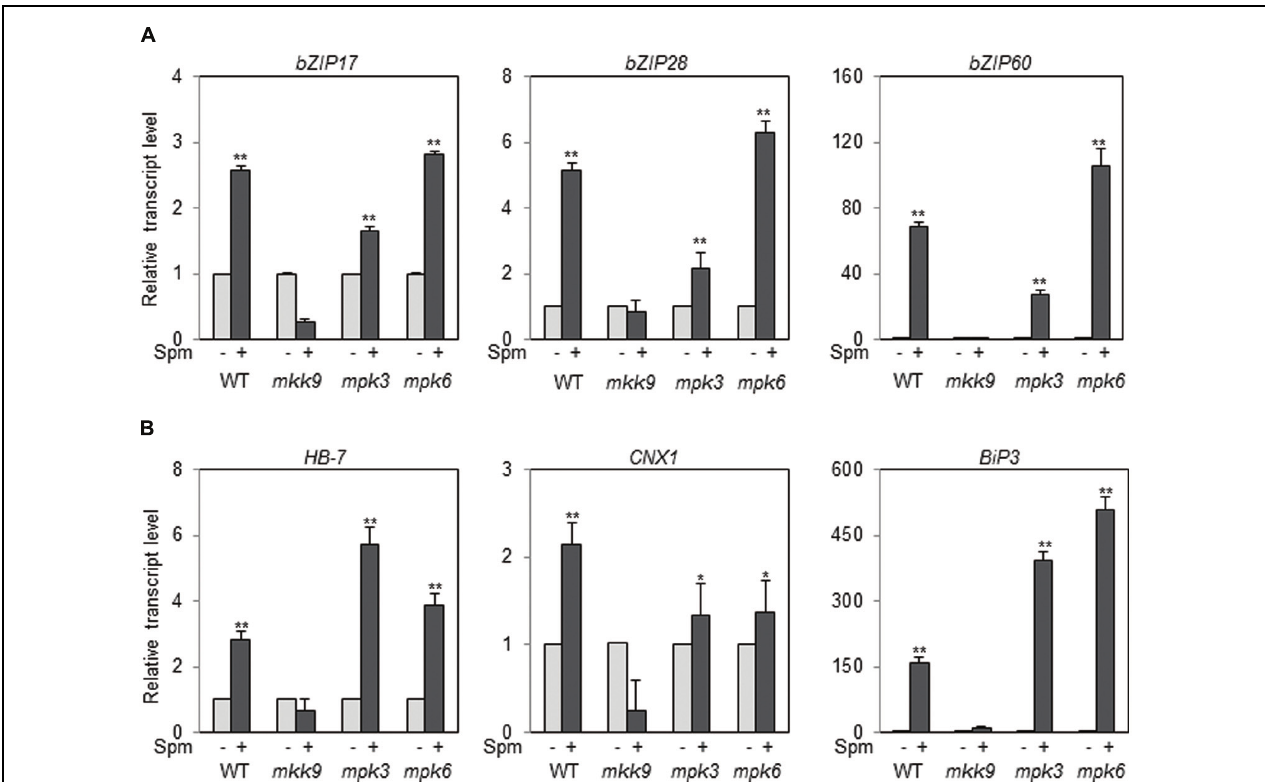
FIGURE 8 | The expression of bZIP17 , bZIP28, and bZIP60 (A) and their target genes (B) in the loss-of-function mutants, mkk9 , mpk3, and mpk6 , upon Spm treatment. The expression levels of the three bZIP genes and their target genes in mkk9 , mpk3, and mpk6 were determined by qRT-PCR. The experiments were performed using three independent biological samples. The mean ± SD were displayed. Asterisks indicate significant difference ( ∗ P < 0.05 and ∗∗ P < 0.01).